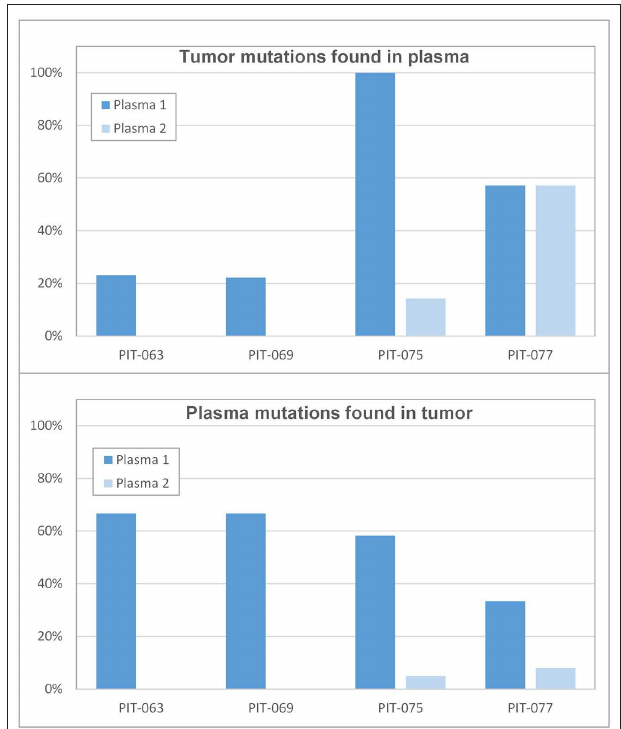
FIGURE 2 | Correlation between tumor and plasma samples ( Top ) percent of tumor mutations that were found in the first (time 0) and second (3 months) plasma samples. ( Bottom ) percent of plasmatic mutations that existed in the original